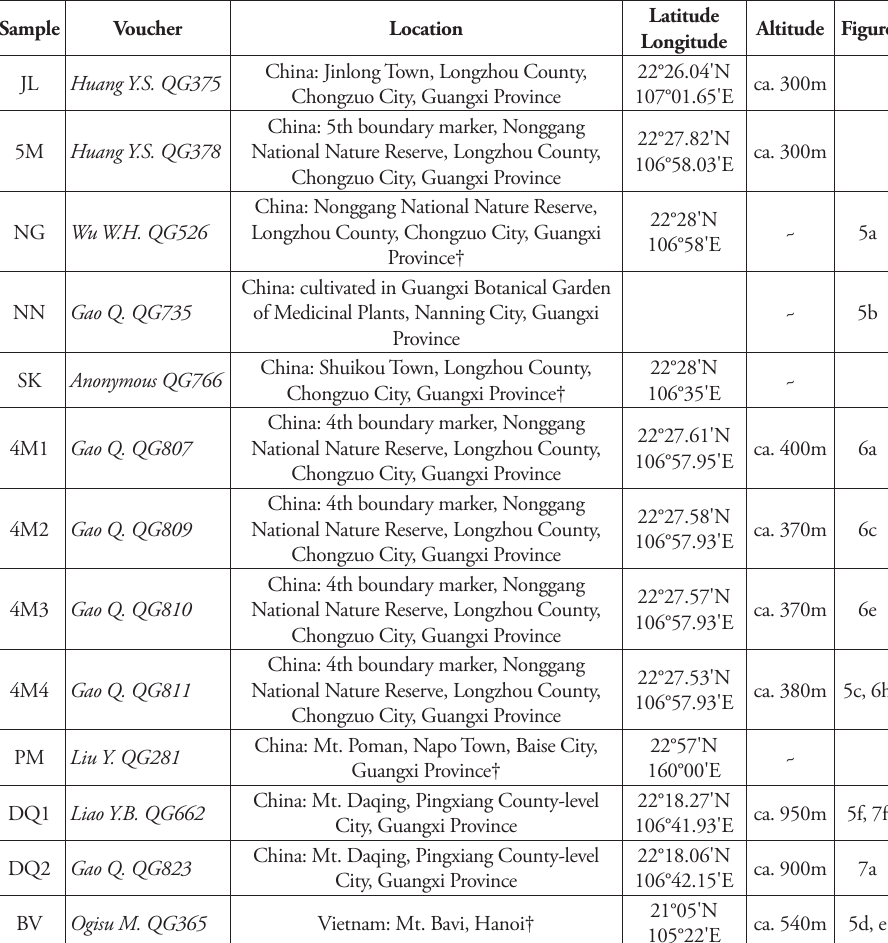
Table 1. Material examined of Aspidistra subrotata .